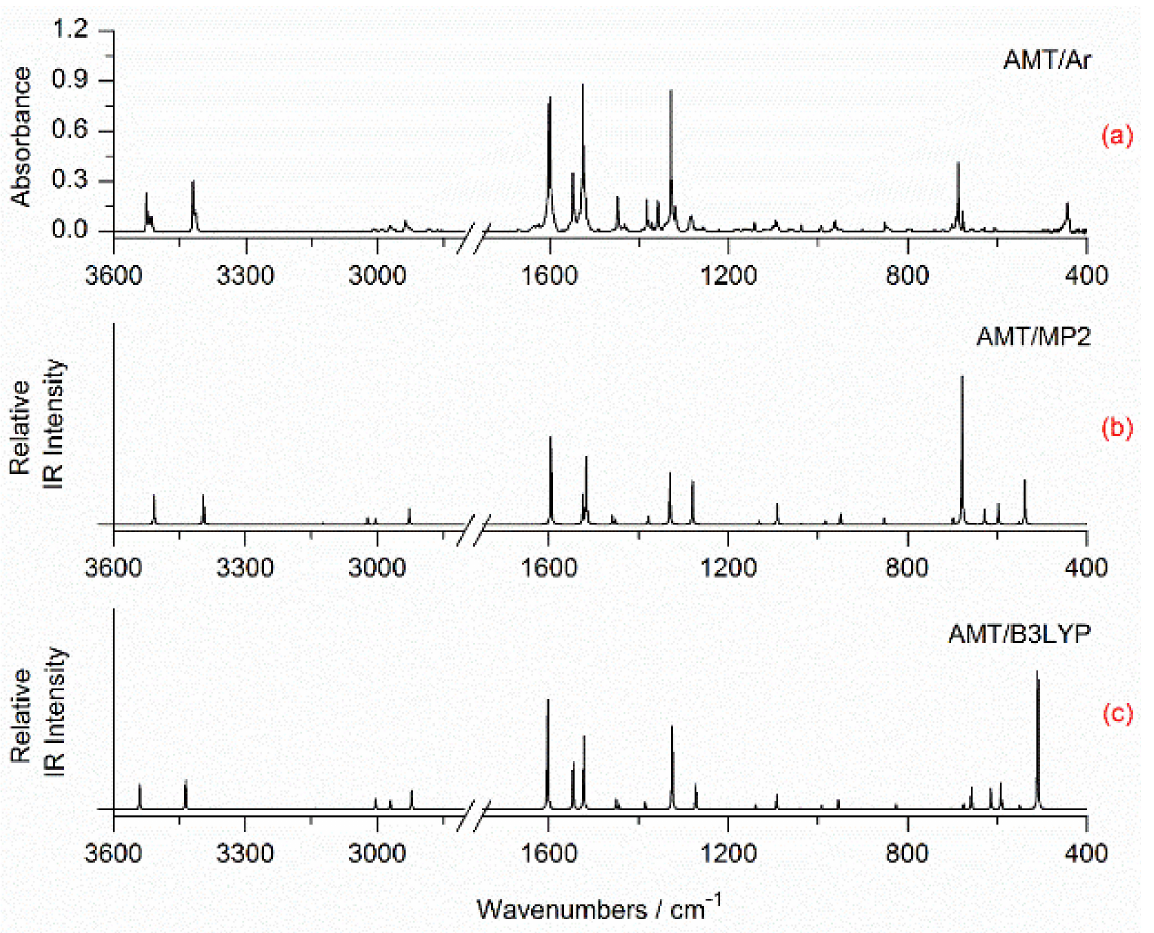
Figure 2. ( a ) Experimental spectrum of AMT isolated in an argon matrix deposited at 15 K and measured at 10 K; ( b ) spectrum of AMT1 tautomer calculated by the MP2/aug-cc-pVTZ method; ( c ) spectrum of AMT1 tautomer calculated by the B3LYP/6-311++G(3df,3pd) method. Table 2. Observed vibrational wavenumbers in an argon matrix (cm − 1 ) compared with the